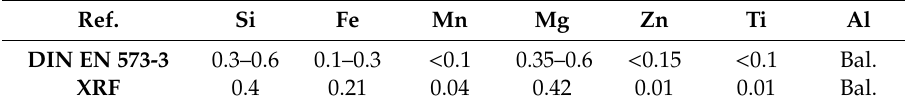
Table 1. Chemical analysis of AW6060 aluminum cast alloy (wt.%).